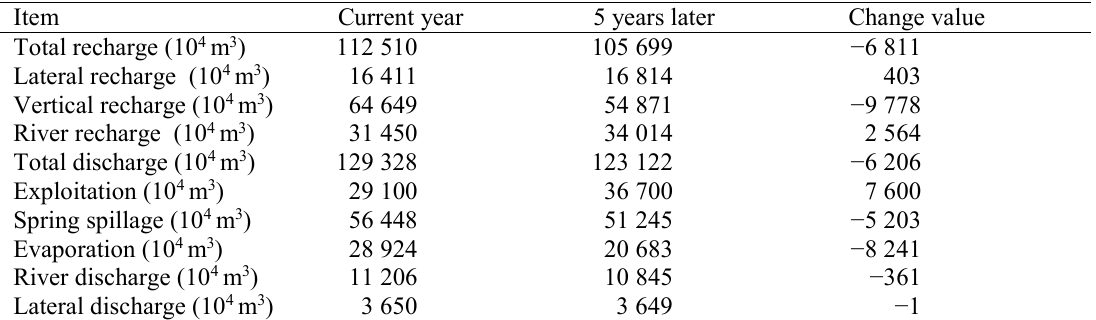
Table 2 The calculated results of water balance in current year and 5 years later by running of the model. Item 5 years